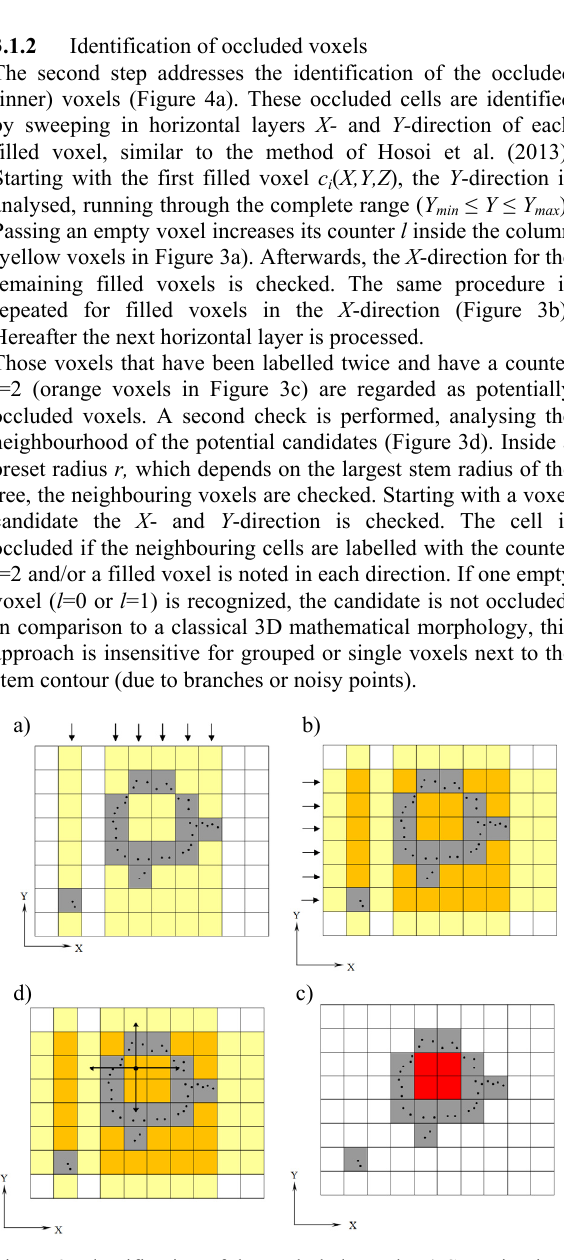
Figure 3. Identification of the occluded voxels: a) Scanning in Y -direction; b) Scanning in X -direction; c) Checking of the candidates; d) Occluded voxels.